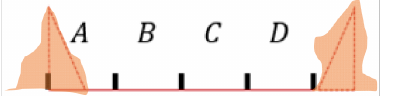
Figure 3. The discrete model of the non-ideal